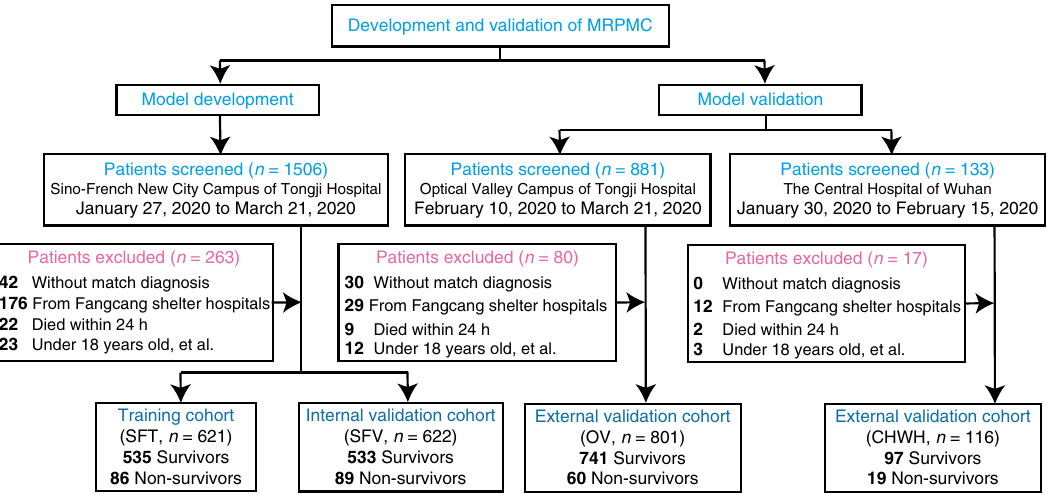
Fig. 1 Study design. MRPMC mortality risk prediction model for COVID-19, SFT training cohort of Sino-French New City Campus of Tongji Hospital, SFV internal validation cohort of Sino-French New City Campus of Tongji Hospital, OV Optical Valley Campus of Tongji Hospital, CHWH The Central Hospital of